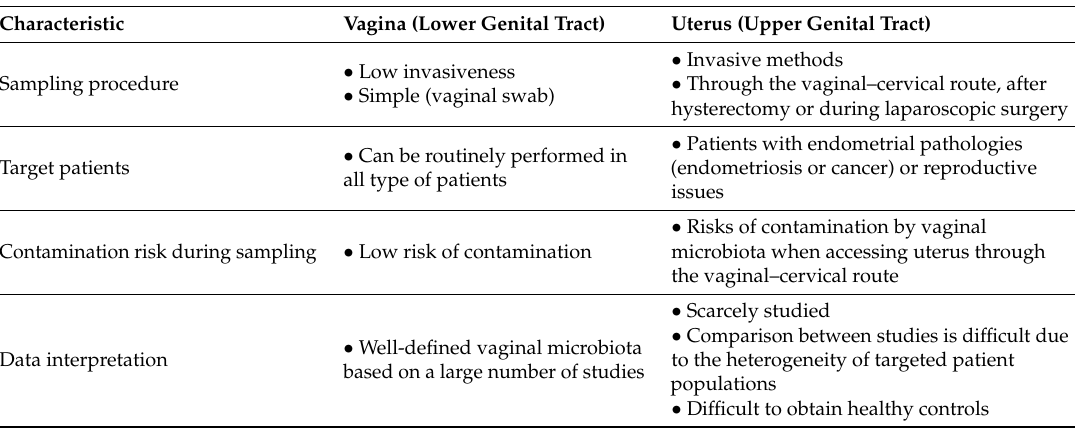
Table 1. Main experimental di ff erences between the analysis of vaginal (lower genital tract) and uterine (upper genital tract)